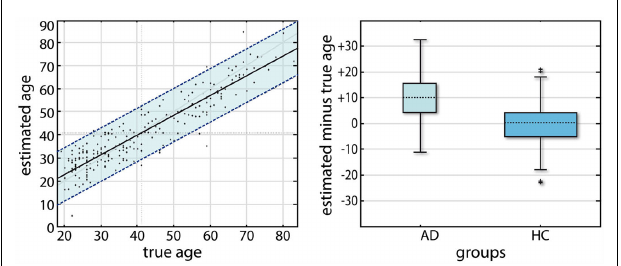
FIGURE 4 |Application of a recognition model of age to cross-sectional voxel-based morphometry (VBM) data (taken from Franke et al., 2010). The recognition model was implemented using a relevance vector machine (RVR) which afterward was trained on 410 healthy subject’s gray matter segments afterVBM preprocessing. Brain-based age estimation results in an independent test sample of n = 245 (left).The overall correlation between estimated and the true age is r = 0.92, and the overall mean absolute error is 4.98years. Box plots of estimation residuals, i.e., estimated age minus true age is shown for two subsamples from the ADNI database (AD with CDR = 1, NO with CDR = 0; right).The gray boxes contain the values between the 25th and 75th percentiles of the samples, including the median (dashed line).The width of the boxes depends on the sample